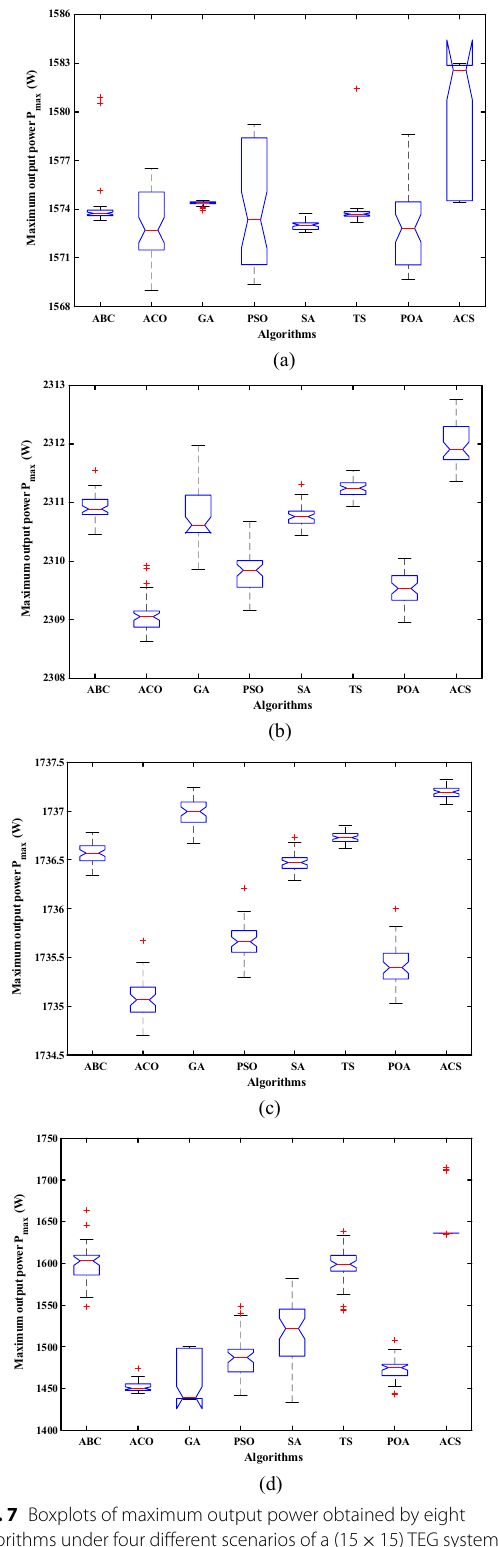
15) TEG system: a ×